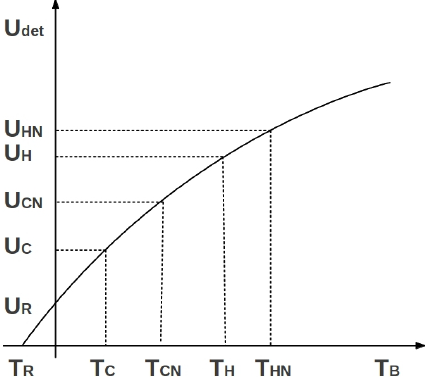
Fig. 2. Schematic illustration of a 4-point calibration. The detector voltage U det is measured at four calibration points: U C , U H , U CN = U C + U N , U HN = U H + U N . T R is the system noise power, U N results from injected noise by the internal noise diode ( T N ). T C and T H are known quantities, T N and the non-linearity parameter α are determined by the calibration.